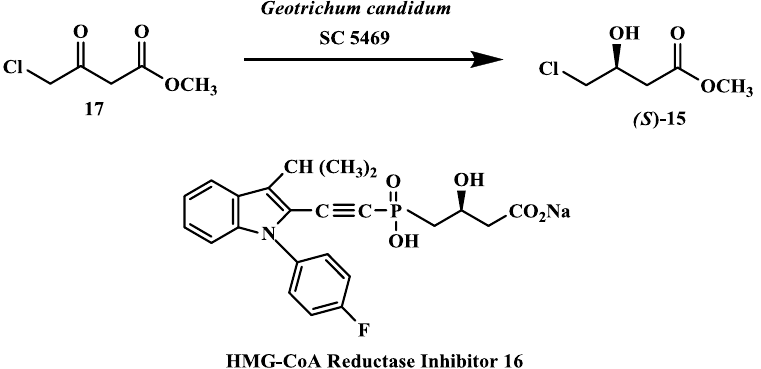
Figure 4. Chloesterol lowering agents: Preparation of ( S )-4-chloro-3-hydroxybutanoic acid methyl